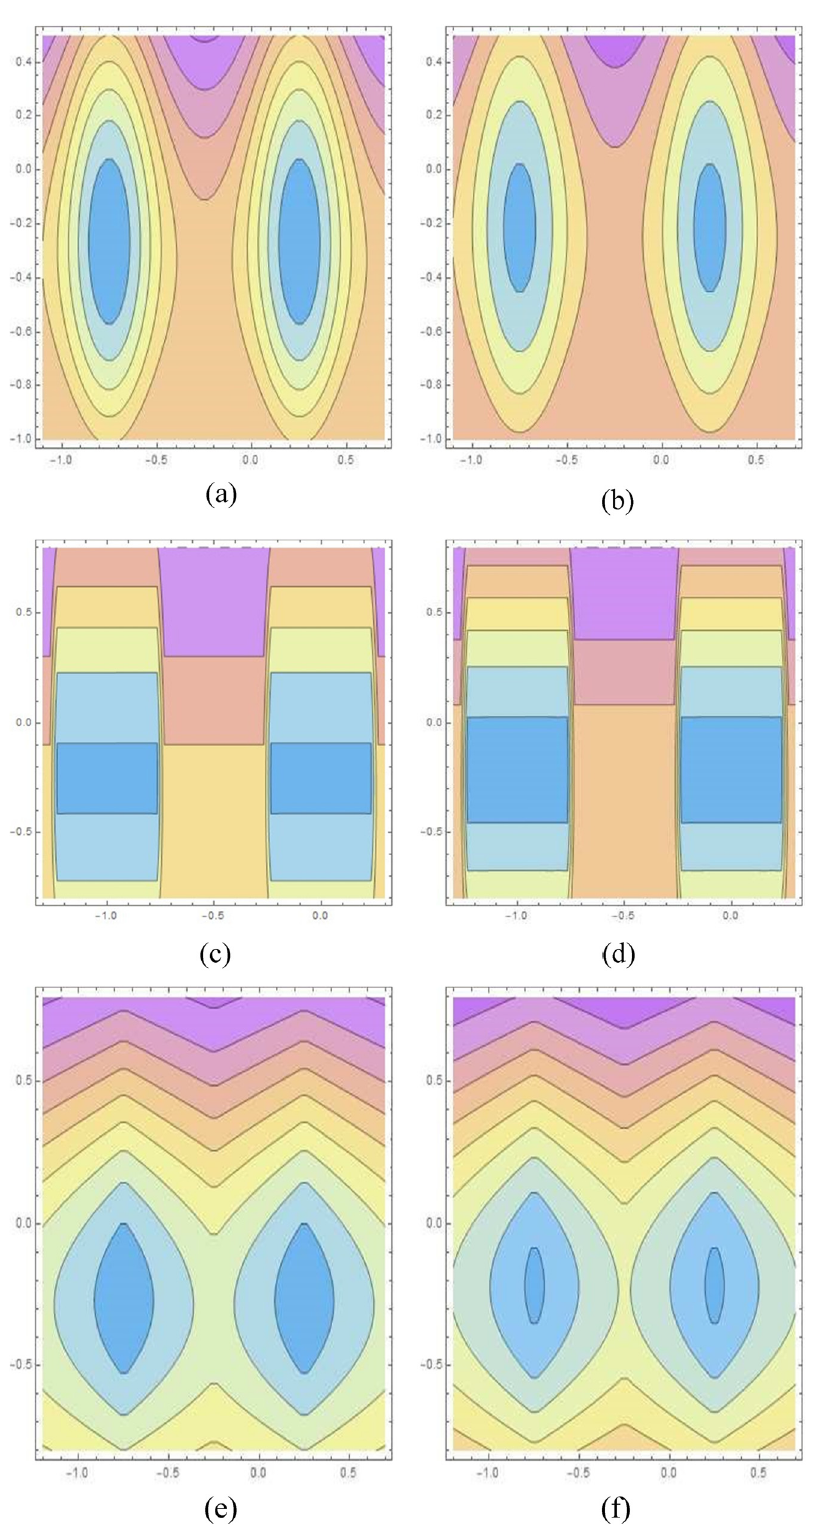
= 0.1, A = 2, Sr = 0.5 A = 1, Br = 0.5, K = 3, Sc = 0.5, ϵ 0.2 = , Gr 0.4 = , K = 2, 1 3 3 1